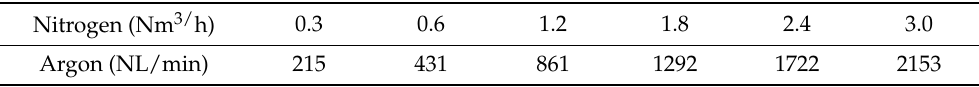
Table 2. Flow rates of gas in model and prototype.